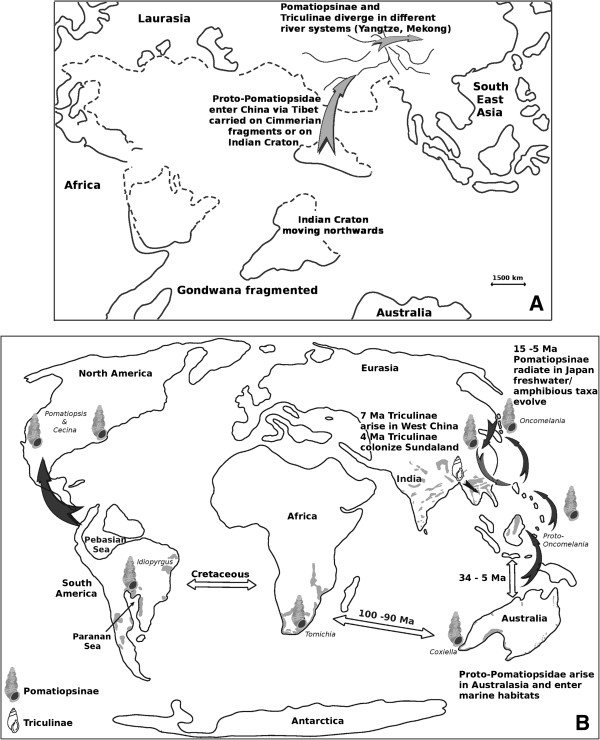
Summary of alternative phylogeographies for the Pomatiopsidae. Semi-schematic showing alternative hypotheses for the origins and evolutionary radiation of the Pomatiopsidae. A. Tibet hypothesis: The ancestor of the Pomatiopsidae arises in Gondwana and is rafted on the Indian Craton after the break up of the super continent. These taxa are then introduced to China via Tibet after the collision between India (or earlier Cimmerian blocks) and Asia (150–120 Ma). The Pomatiopsinae and Triculinae then diverge in the Yangtze and Mekong river systems as these cut their way southwards to the sea [10]. B. Hunan (East to West) hypothesis, as proposed by Attwood (2009) [9]: Proto-Pomatiopsinae diverge in Australasia, with marine forms developing and colonizing South Africa and South America. Precursors of Oncomelania colonize northwards along island chains created by low sea levels and by tectonic movements (rafting). After reaching Japan, Proto-Oncomelania gives rise to the Japanese Pomtiopsinae and Oncomelania hupensis; the latter colonizes China and back-tracks (grey stippled arrow) to recolonize the Philippines and Sulawesi (replacing antecedent forms). The Triculinae arise in Southwest China and diverge in uplifting mountain areas. Dates are from the present analyses. Approximate distributions of major formations of calcareous rocks are shown as shaded areas. Coastlines are rough approximations for 15–10 Ma, drawing from the palaeogeographical literature [31-39].